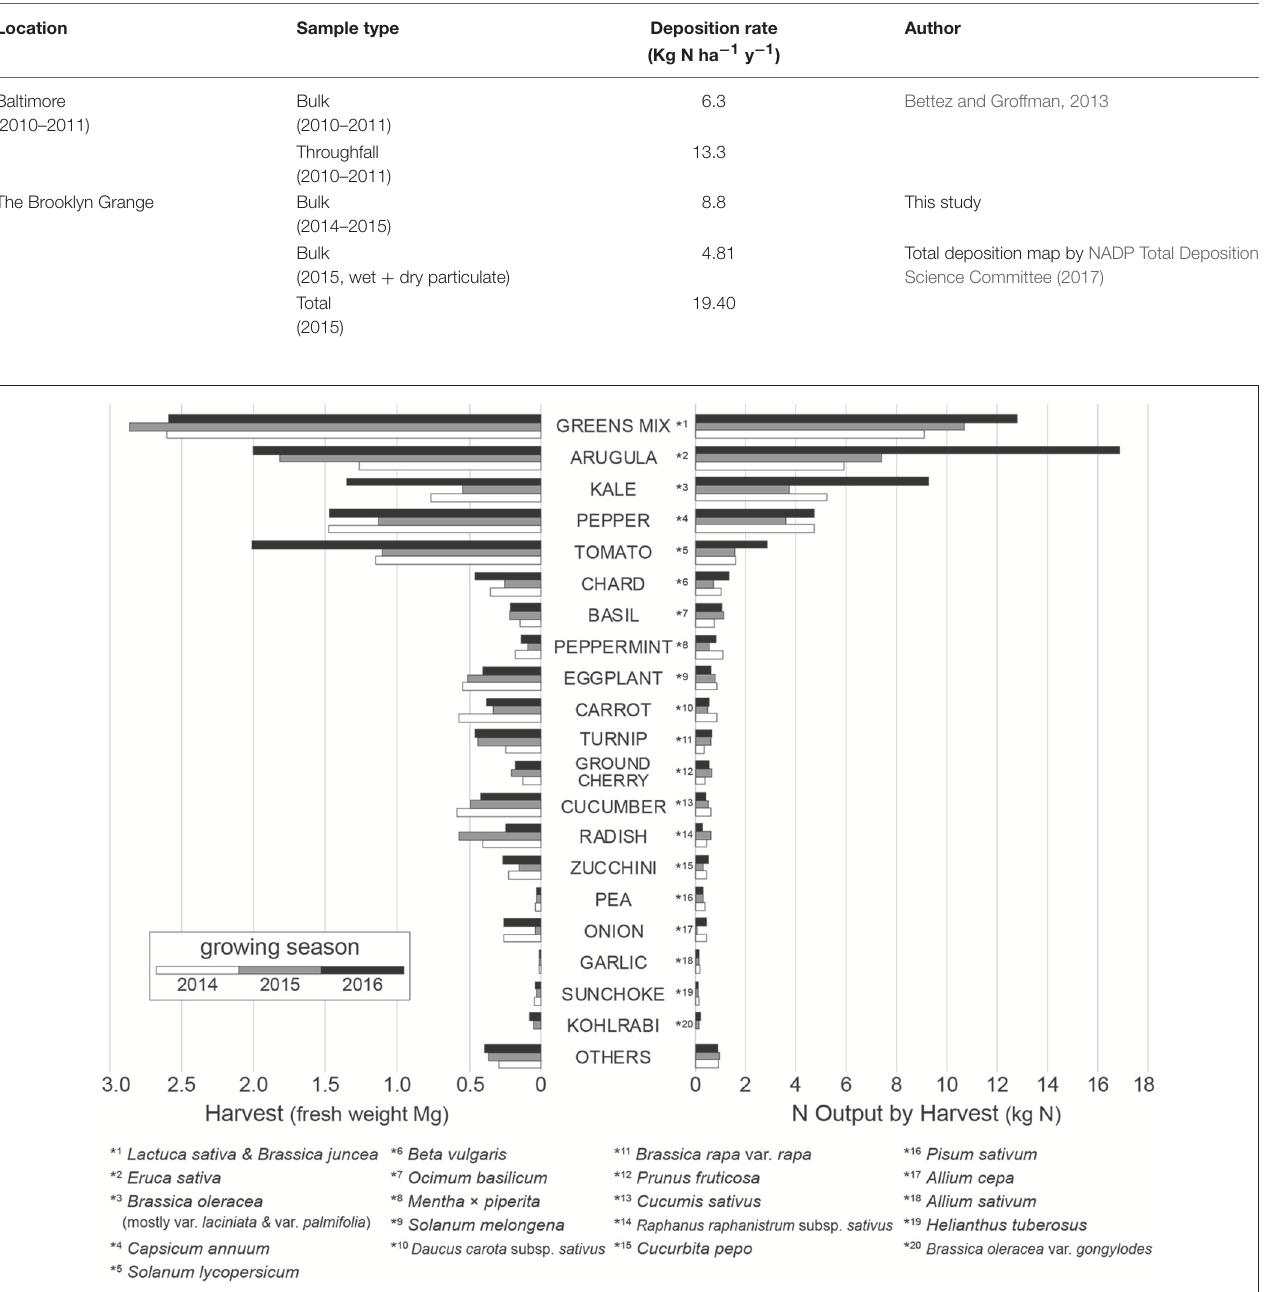
FIGURE 5 | Fresh weight and N content of the harvested vegetables over the 2014, 2015, and 2016 growing seasons at the Brooklyn Grange Navy Yard farm, NYC. Crops are listed in order of the N contents over three growing seasons combined.